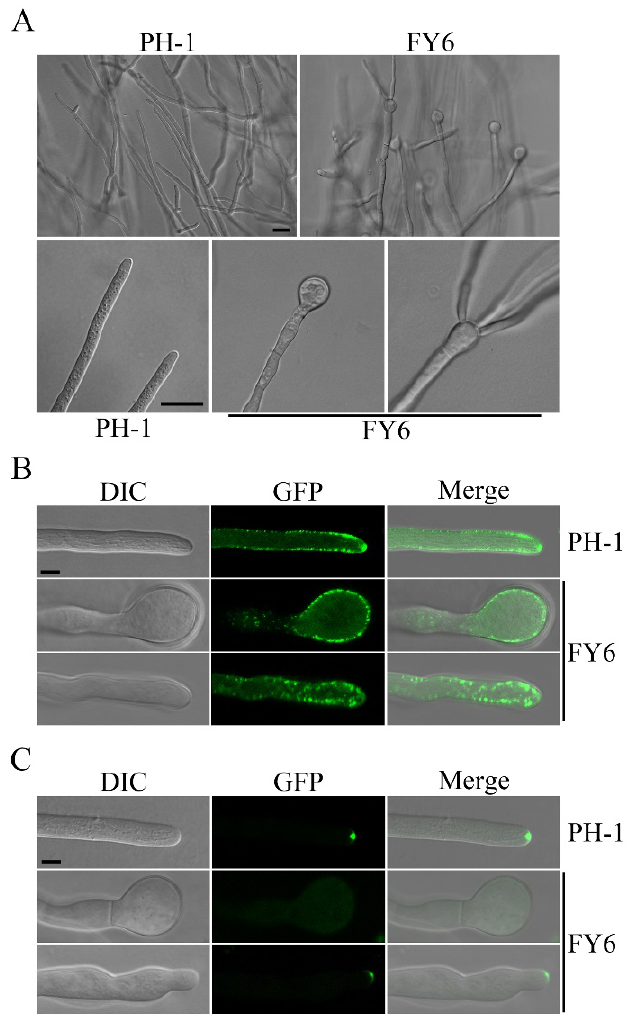
Figure 5. The Fgyck1 mutant is defective in maintaining polarized hyphal growth. ( A ) Hyphae of PH-1 and Fgyck1 mutant (FY6) from 36-h-old PDA cultures. Swollen hyphal tips were observed in the Fgyck1 mutant and some of them produced one or multiple new tips or hyphae. Bar, 20 µ m. ( B ) Hyphal tips of transformants of PH-1 and Fgyck1 mutant FY6 expressing the LifeAct-GFP construct were examined by confocal microscopy. The enrichment of LifeAct-GFP at the core of Spk is not observed in normal or swollen hyphal tips of the Fgyck1 mutant. Bar, 5 µ m. ( C ) Hyphal tips of transformants of PH-1 and FY6 expressing the FgSpa2-GFP construct were examined by confocal microscopy. Localization of FgSpa2-GFP to the polarisome was absent in swollen tips and reduced in normal tips in the Fgyck1 mutant. Bar, 5 μm.